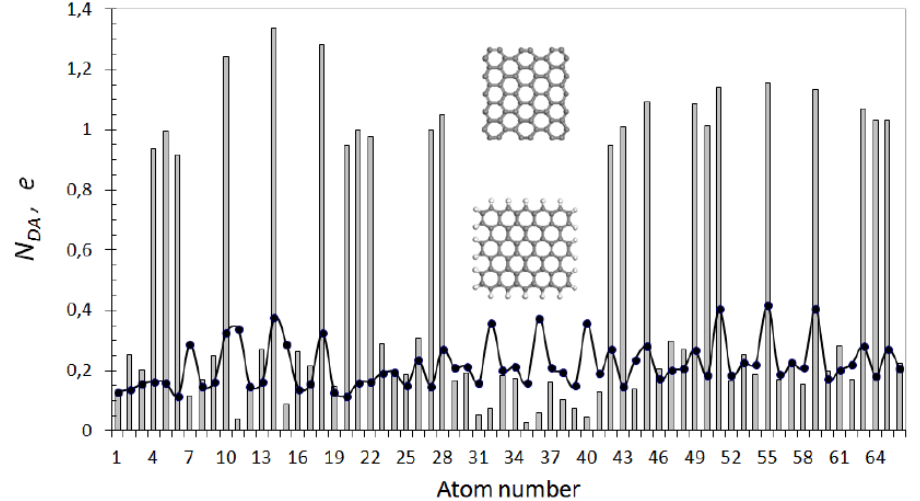
Figure 4. Standard ACS N DA image maps over atoms of (5, 5) NGr molecule with empty (histogram) and hydrogen-terminated (curve with dots) edges. Insert: equilibrated structures of the parent (5, 5) NGr molecule and its monohydrogenated homologue peri